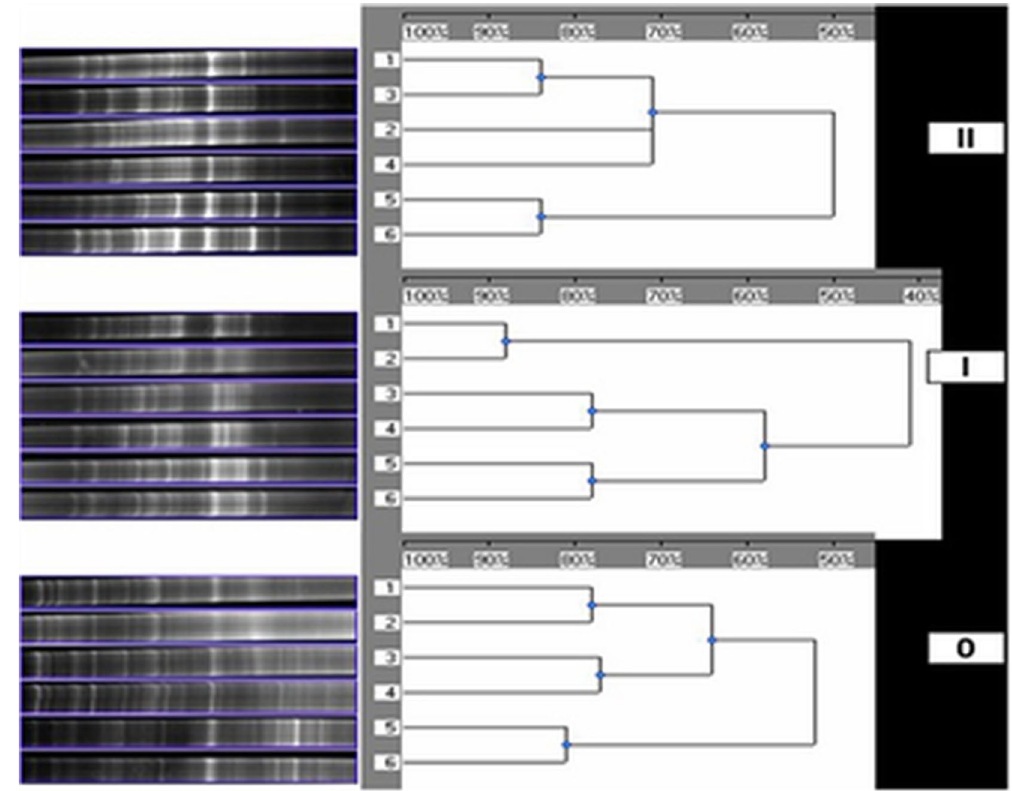
Figure 2. Cluster analysis of the gel given in Fig. 1. ( II ) DNA-based SSCP fingerprints of the highly PCBs- contaminated soil samples. ( I ) DNA-based SSCP fingerprints of the slightly contaminated soil samples. ( 0 ) DNA-based SSCP fingerprints of clean